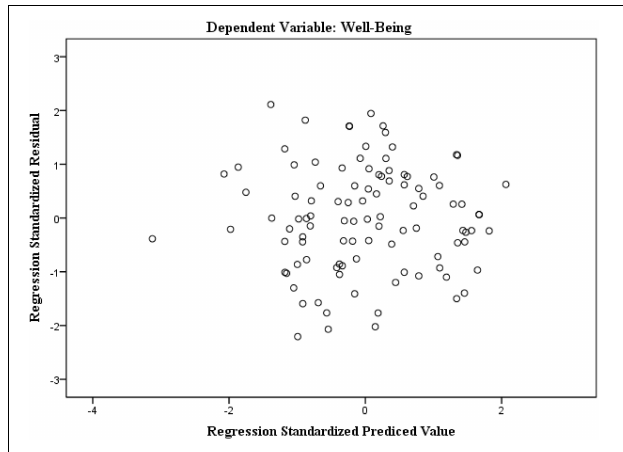
FIGURE 2 | The scatterplot of the standardized residuals against standardized predicted